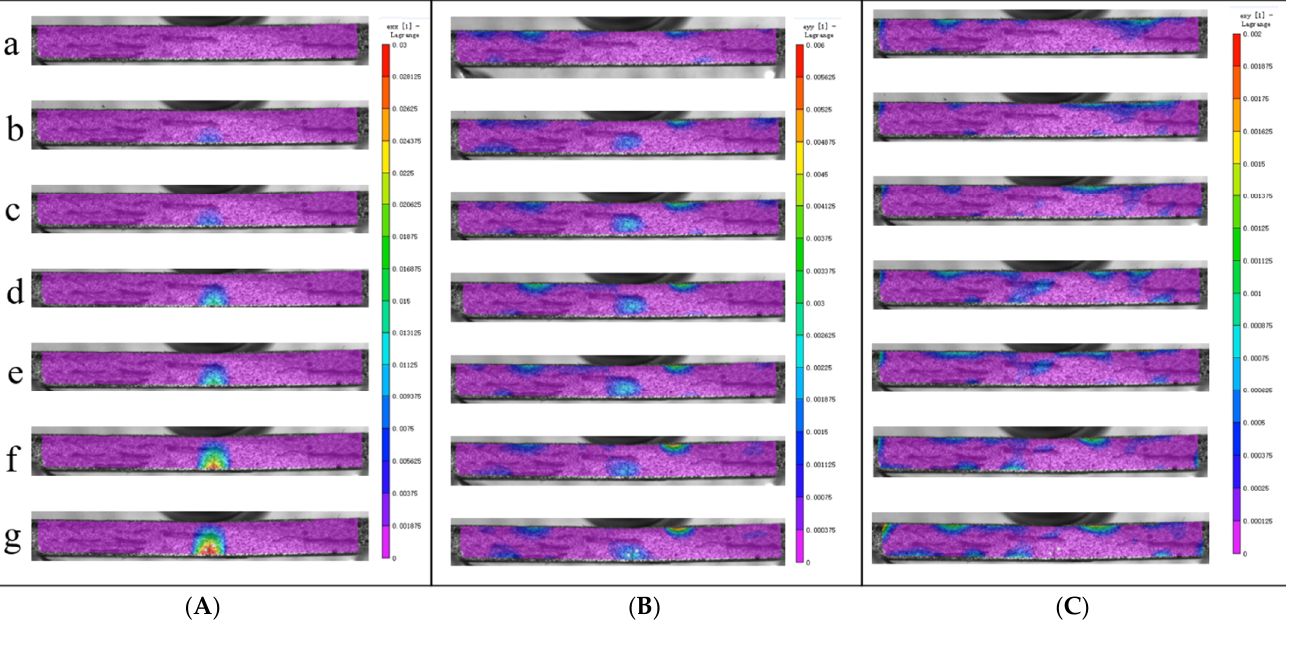
Figure 12. The tensile and compressive strains on the surface of the specimen are focused